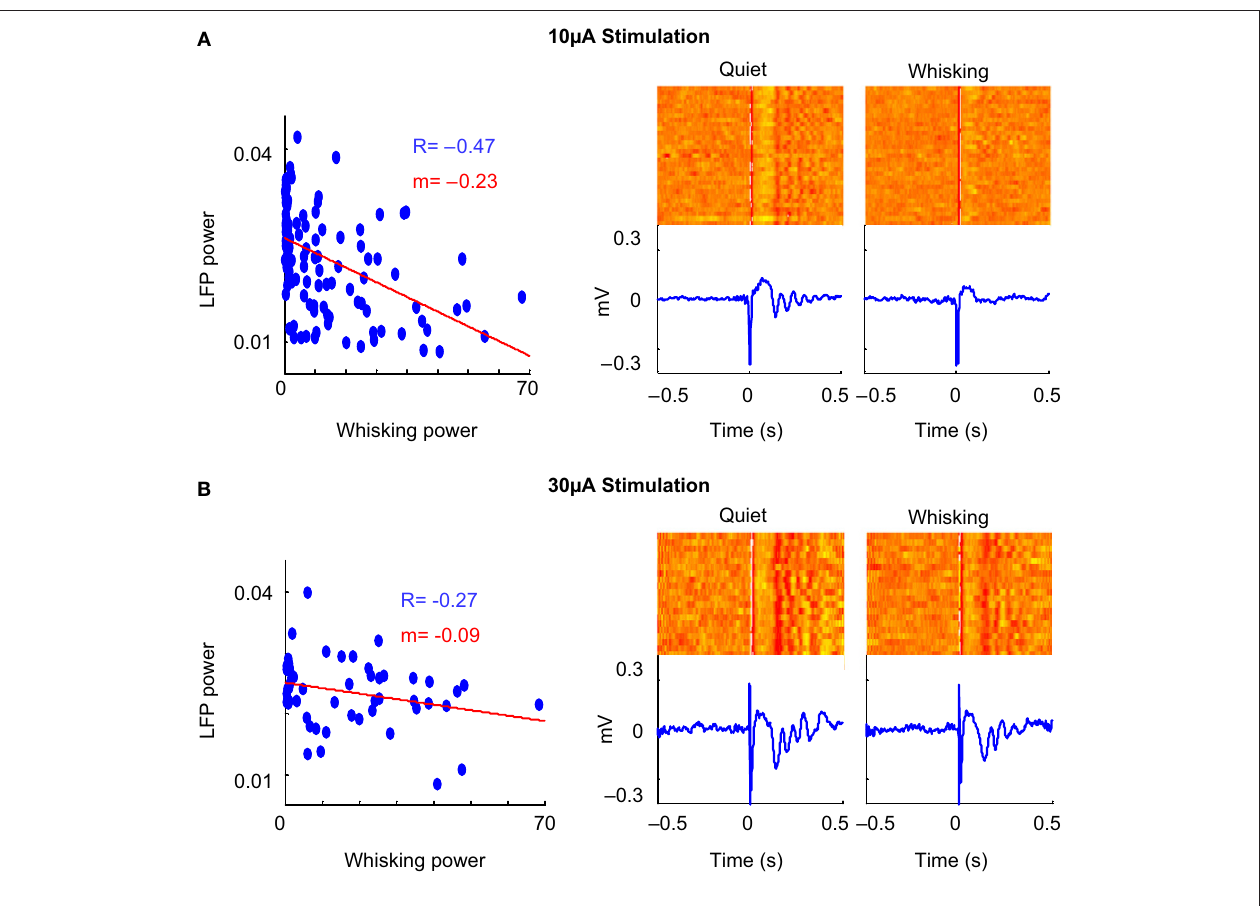
denoted by ‘ R ’ ( P < 0.05 in both cases) and slope of the linear fi t of the scatter plot is denoted by ‘ m ’. (B) Neural response to microstimulation at 30 µA shows evoked oscillations irrespective of behavioral state.